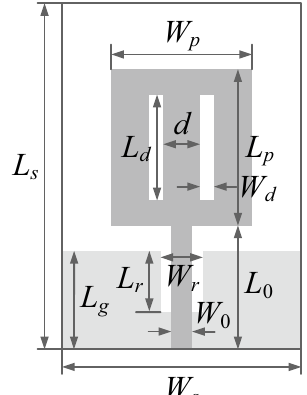
Figure 1. Absolute parameterization for an exemplary monopole antenna 55 (ground plane marked using the light-shade grey). The geometry is described by the variable vector x = [ L s L 0 L p L d L r L g W s W r W p W d d ] T ; variable